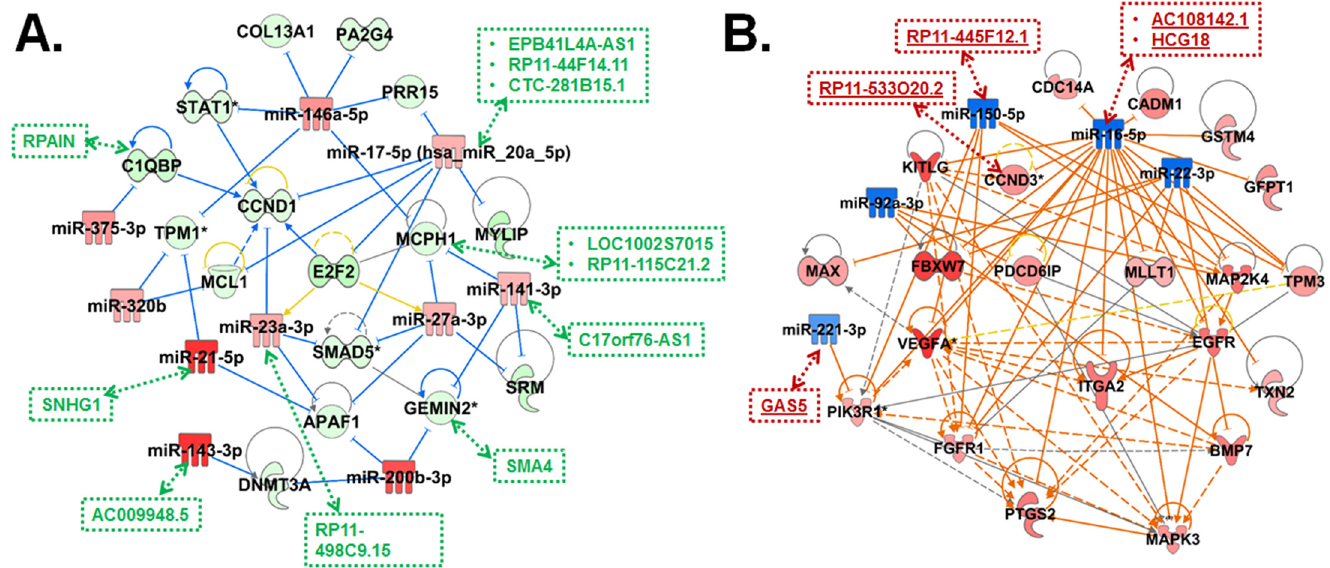
Fig 5. The regulatory network of ncRNAs and mRNAs in workers exposed to MWCNTs. The regulatory networks of significantly dysregulated lncRNAs and mRNAs (p-value < 0.05, fold-change >± 1.5) having positional and/or functional relationship with (A) up-regulated miRNAs (p < 0.05, fold-change > 1.5) and (B) down-regulated miRNAs (p > 0.05, fold-change > -1.5), generated using IPA. The lncRNAs, represented using red ( # ) and green ( " ) rectangles and dotted lines, with consistent co-expression as mRNAs and/or containing miRNA target binding sites from starBase v2.0 were manually added to the